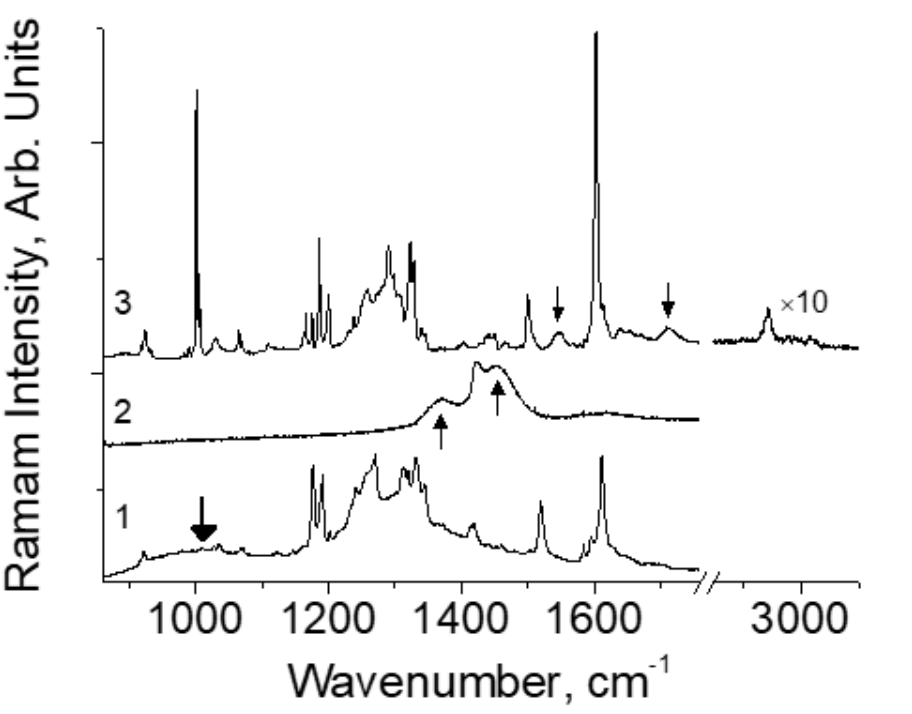
Figure 6. Raman spectra of Me-DBM ( 1 ), (DMF) 2 H ( 2 ), and DBM ( 3 ) at 5 K in the range of hydrogen bond vibrations. The positions of the H-bond bands are marked with